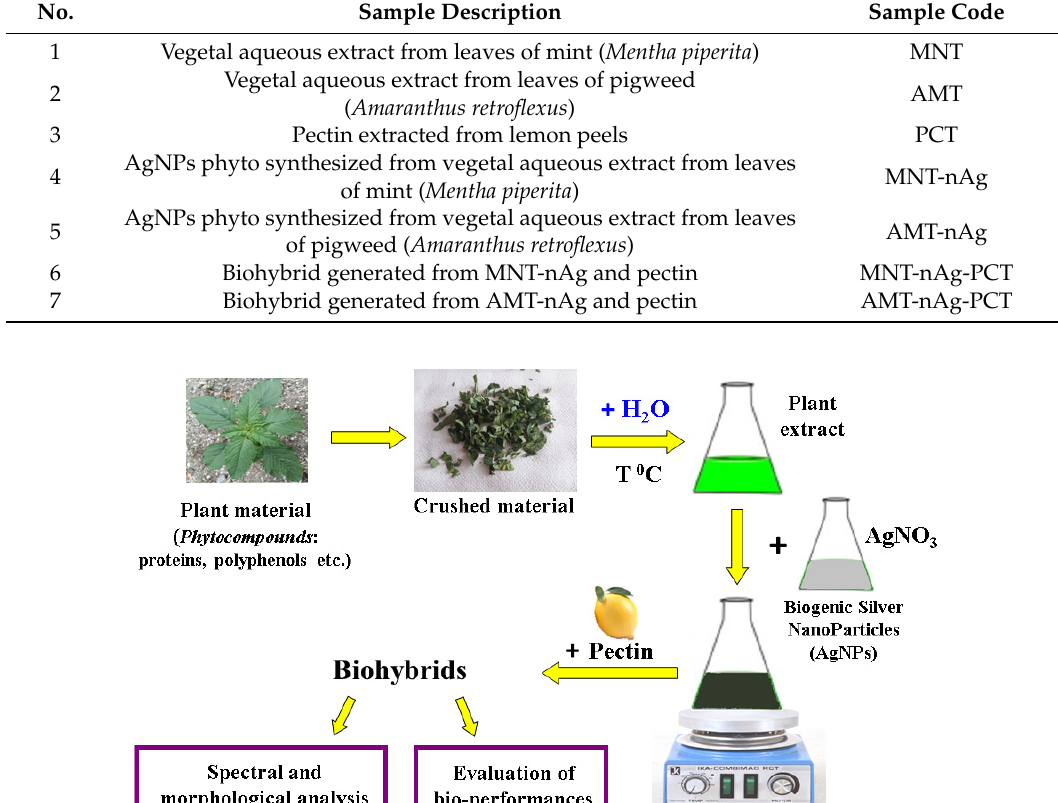
Table 1. Sample descriptions and their corresponding codes.